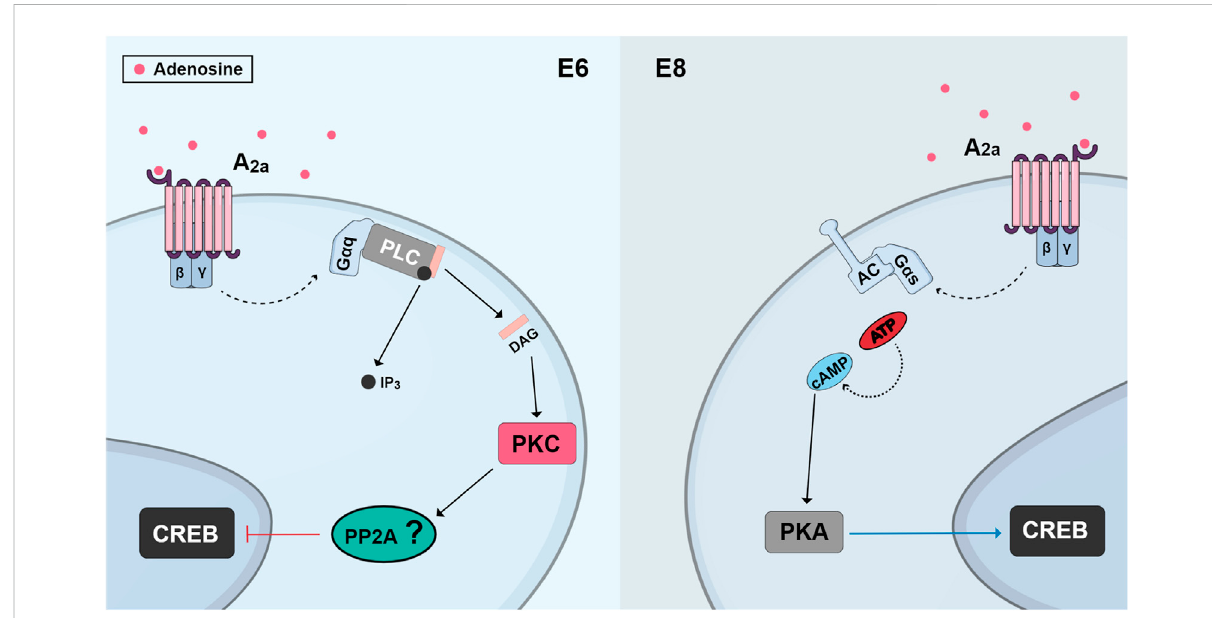
FIGURE 7 Schematicview ofchanges observed inCREB regulation by A2a receptorsin differentages of cultures from developing chick retina. Incultures obtained from E6 retinas, activation of A2a receptors promotes phospholipase C/PKC stimulation and CREB dephosphorylation, probably through the activation of a phosphatase, leading to cell death. On the other hand, in cultures from E8 embryos, activation of A2a receptors promotes CREB phosphorylation, through a cAMP/PKA pathway, and cell